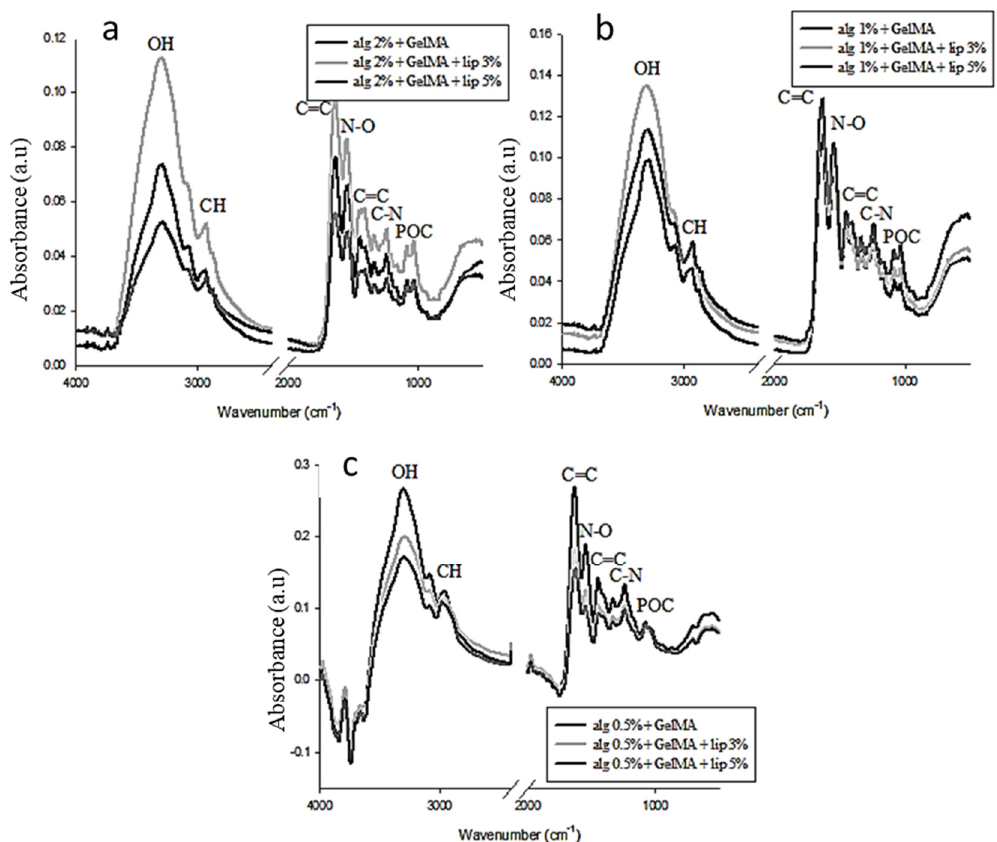
Figure 2. Surface analysis by FTIR of the mixture of GelMA and alginate with different concentrations of alginate. ( a ) Spectra of the mixtures with 2% ( m / v ) alginate, ( b ) spectra of the mixtures with 1% ( m / v ) alginate, and ( c ) spectra of the mixtures with 0.5% ( m / v ) alginate.